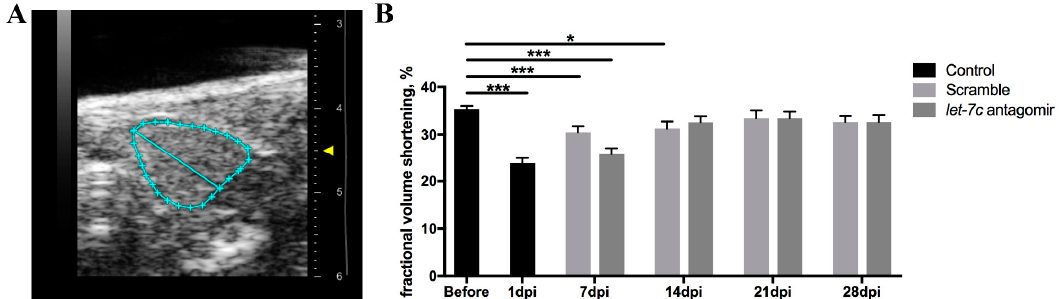
Figure 6. Echocardiography to assess cardiac function. The epicardial border is marked ( A ). FVS measured from recorded B-mode videos before cryoinjury, and at 1 dpi, 7 dpi, 14 dpi, 21 dpi, and 28 dpi ( B ). ( n = 60 for before, n = 18 for 1 dpi, n = 29 for 7 dpi antagomir, n = 30 for 7 dpi scramble, n = 28 for 14 dpi antagomir, n = 29 for 14 dpi scramble, n = 16 for 21 dpi antagomir, n = 18 for 21 dpi scramble, n = 16 for 28 dpi antagomir and n = 17 for 28 dpi scramble). * p ≤ 0.05, *** p ≤